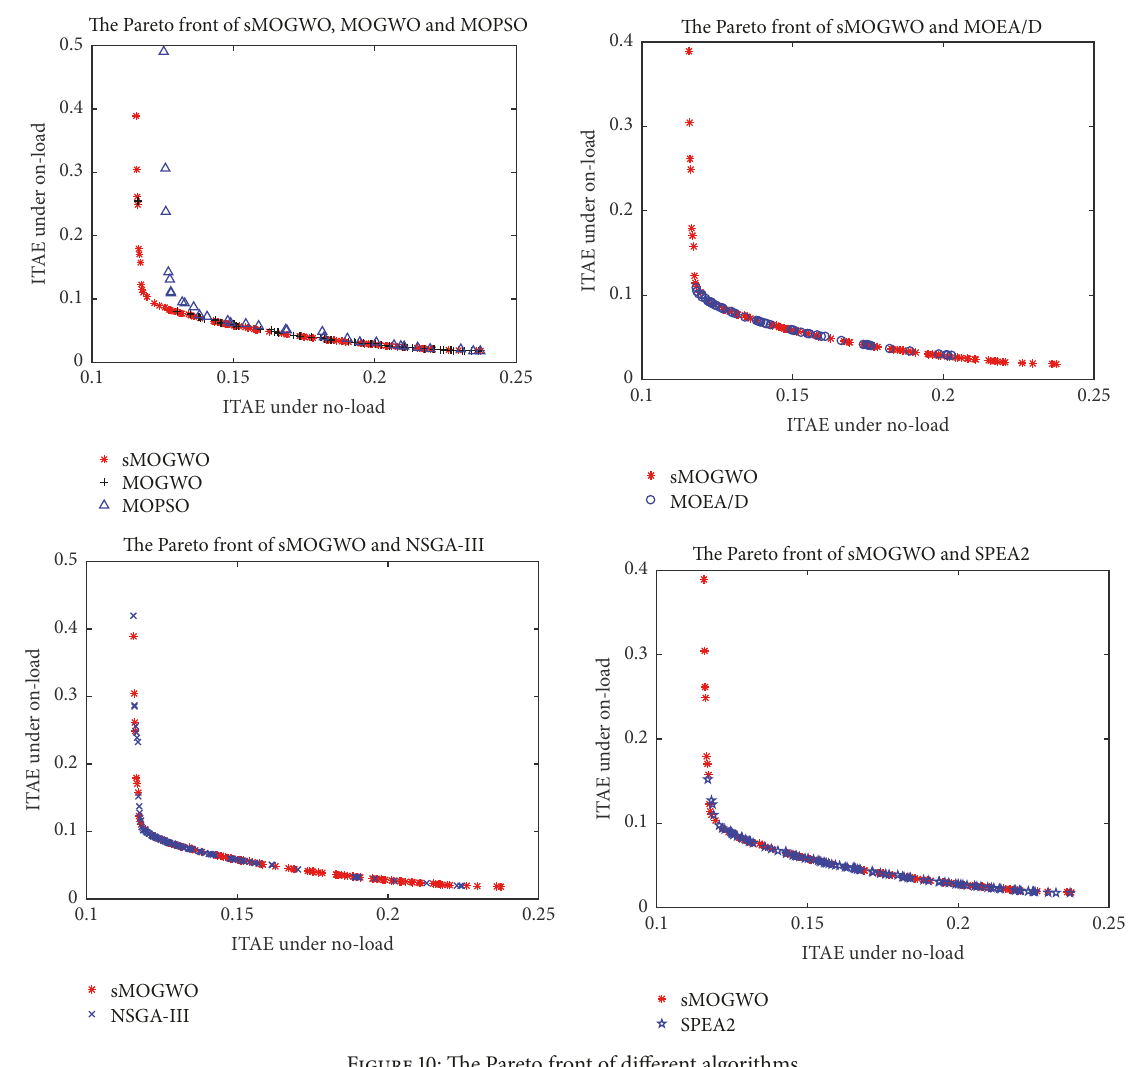
Figure 10: The Pareto front of different algorithms.